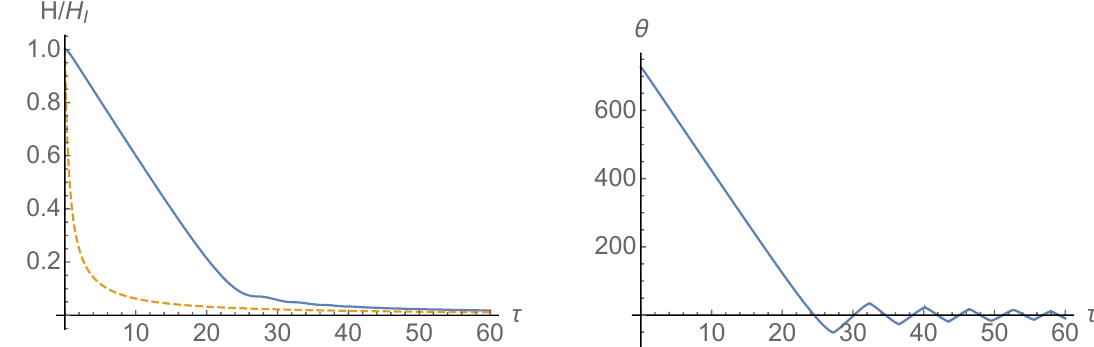
Figure 5 . The evolution of the Hubble parameter (left panel) and the in(cid:13)aton value (right panel) with respect to (cid:28) = H I t in the case with h 0 = (cid:3) = 67. The dashed line in the left panel is the Hubble evolution of the standard matter domination.